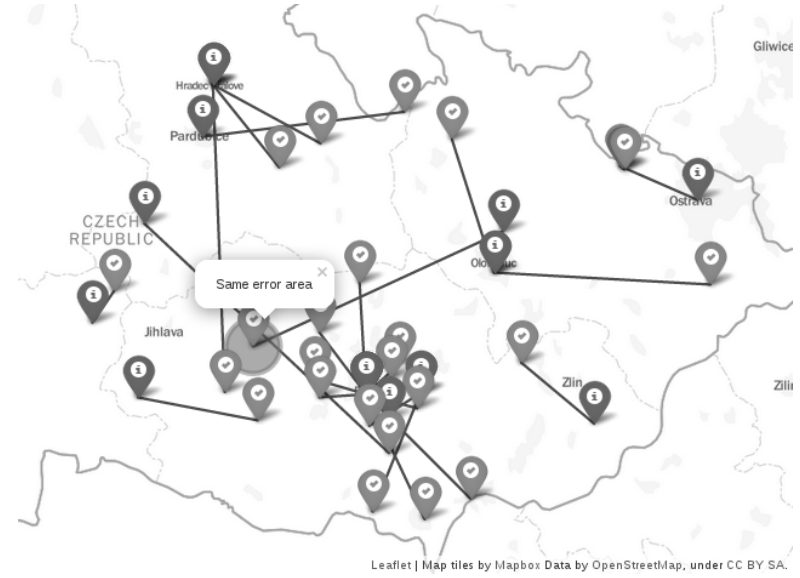
Figure 2. Same error